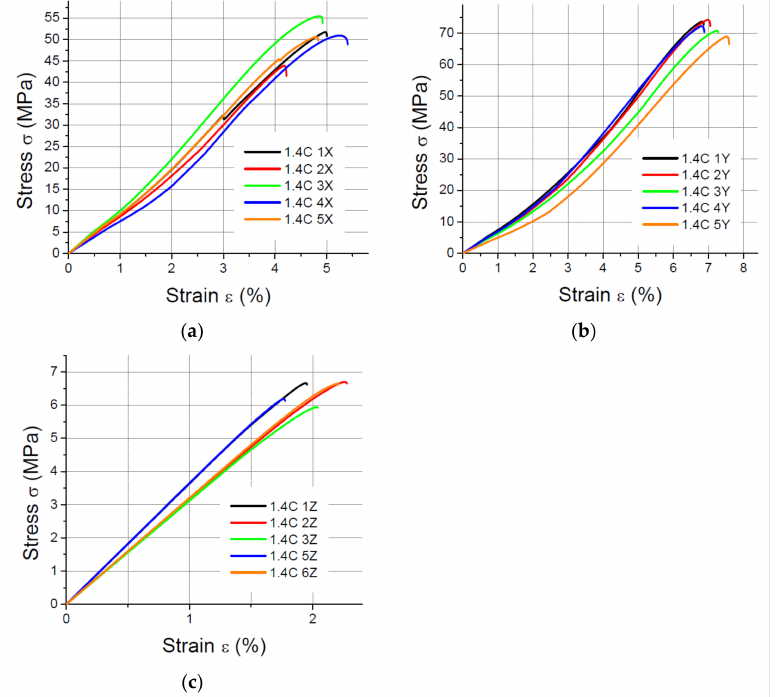
Figure 9. Tensile test results for 1.4 mm thick specimens made of PLA-CF printed in ( a ) the X orientation; ( b ) the Y orientation; ( c ) the Z